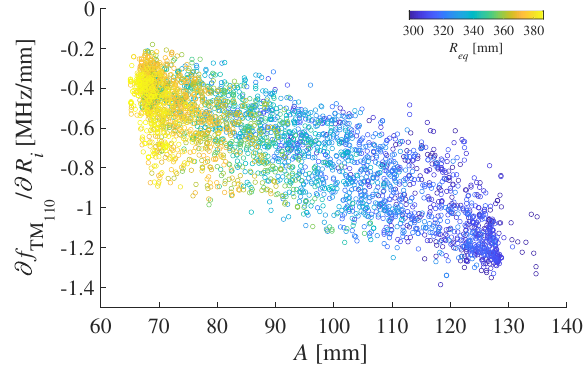
FIG. 4. The local sensitivity of the frequency of the TM 110 mode with respect to R i plotted versus A . Around 5 ’ 000 samples of cavities with different values of R eq , L , A , B , a , b and R i are studied, and the frequency of the FM of each sample is tuned to 400.79